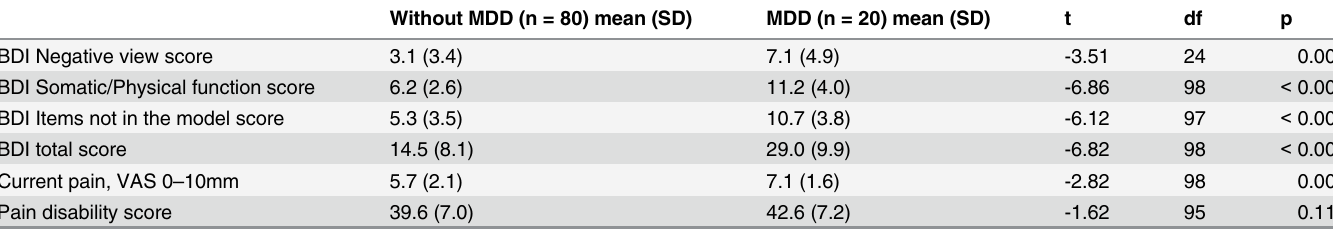
(Table 4), the current pain intensity and the BDI somatic/physical function scales were associ- ated with the current MDD diagnosis, while the negative view of self and the pain disability Table 3. Comparison of the BDI and pain scales by the diagnosis of Major Depressive Disorder